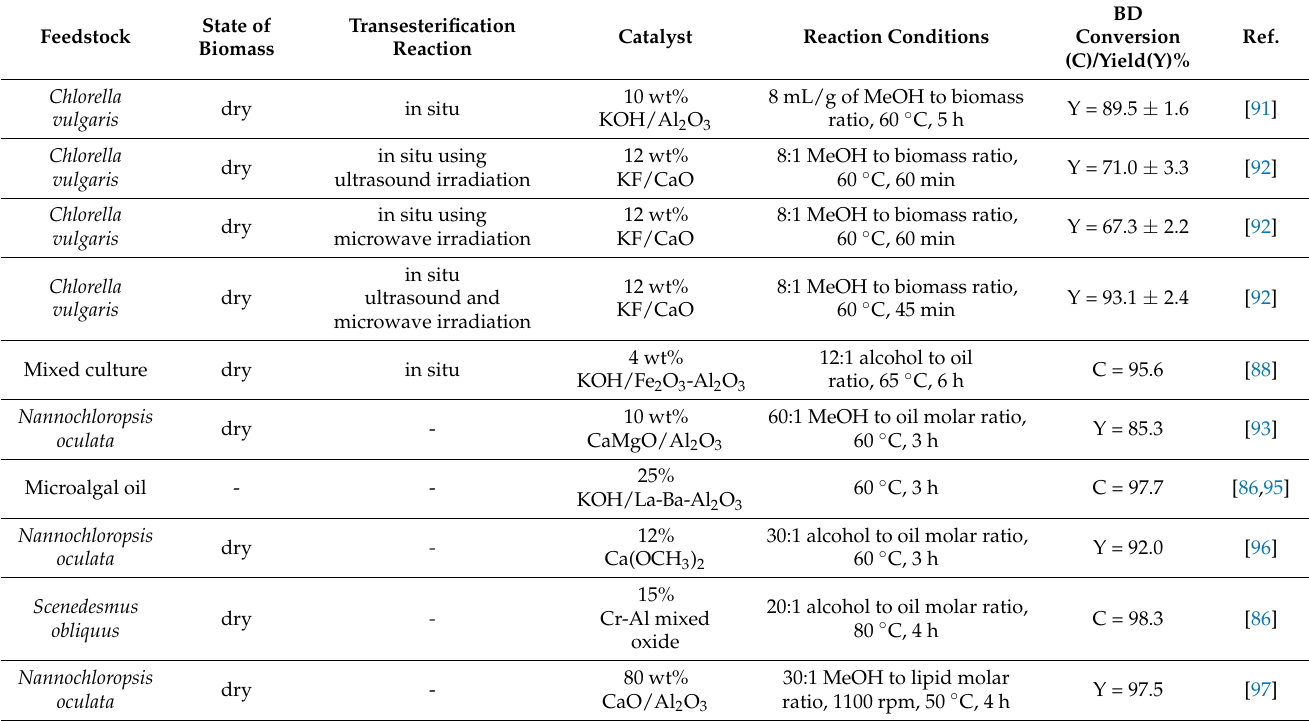
Table 4. BD production using various heterogeneous alkali